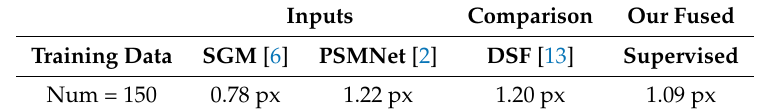
Table 8. Mean absolute disparity error of stereo-stereo fusion on Kitti2015 (50 test samples). Inputs Comparison Our Fused Training Data SGM [6] PSMNet [2] DSF [13] Supervised